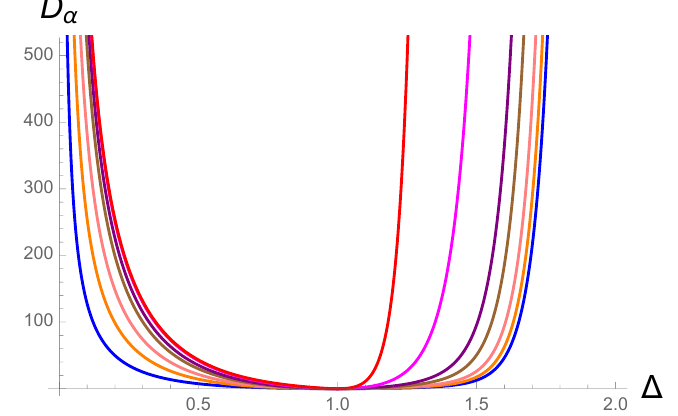
Figure 2 . Holographic R(cid:19)enyi divergence for a cuto(cid:11) ~ (cid:15) = 0 : 0001 and inverse temperature (cid:12) = 2 (cid:25)